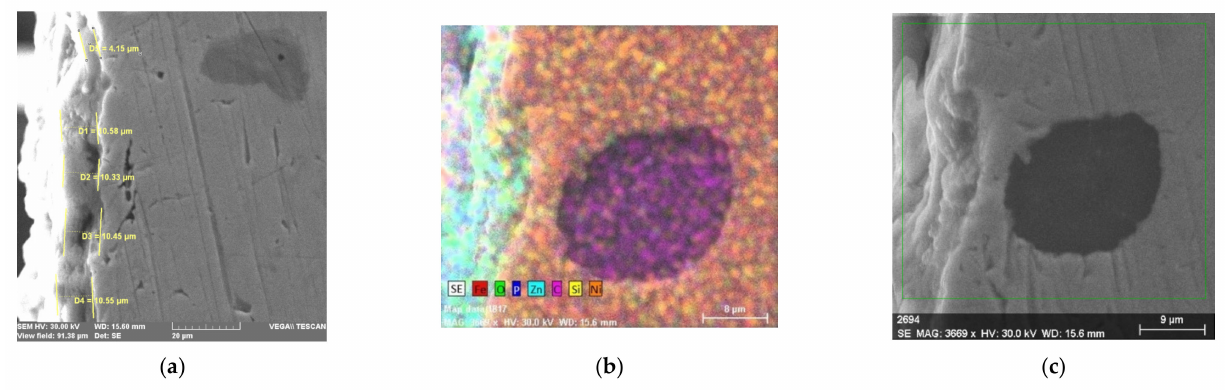
Figure 3. SEM micrographs of the nodular cast iron coated with Zn phosphate layer ( a ) 100 × ; ( b ) 500 × ; ( c ) 1000 × .